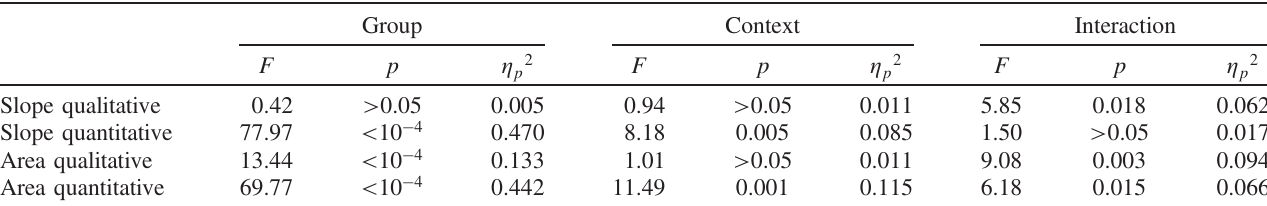
TABLE I. Results of the two-way ANOVAs conducted on students ’ scores on qualitative and quantitative questions about graph slope and area under a graph with factors group (physics students vs psychology students) and context (physics vs